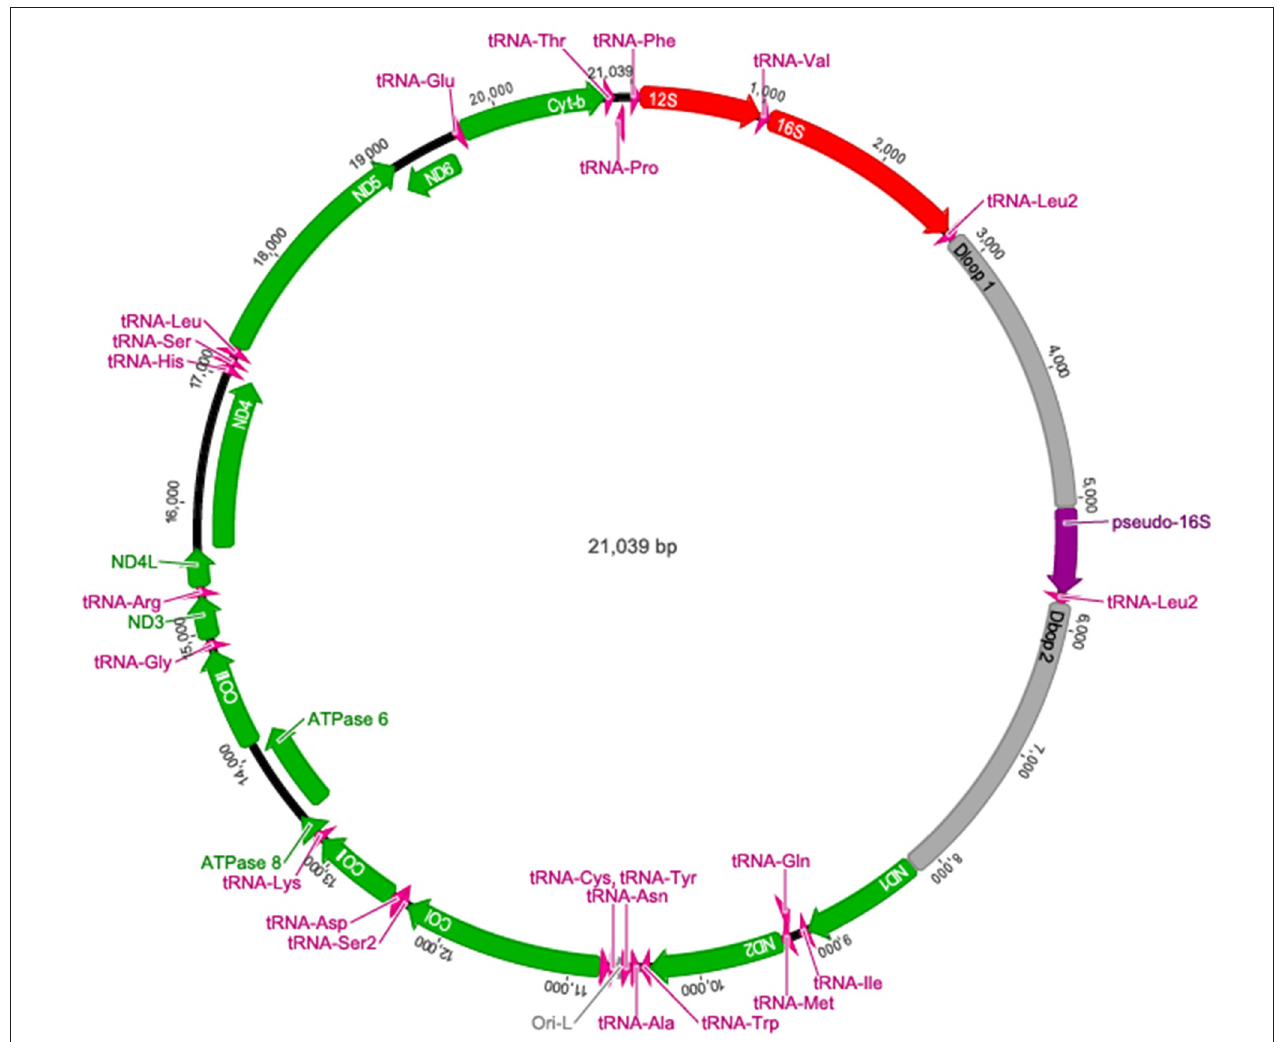
FIGURE 1 | The complete annotated mtgenome of A. limnaeus . Protein coding genes are noted in green, tRNAs in pink, D-loops and the origin of light strand replication (abbreviated Ori-L) are in gray, rRNA in red, and the pseudo-16S rRNA in